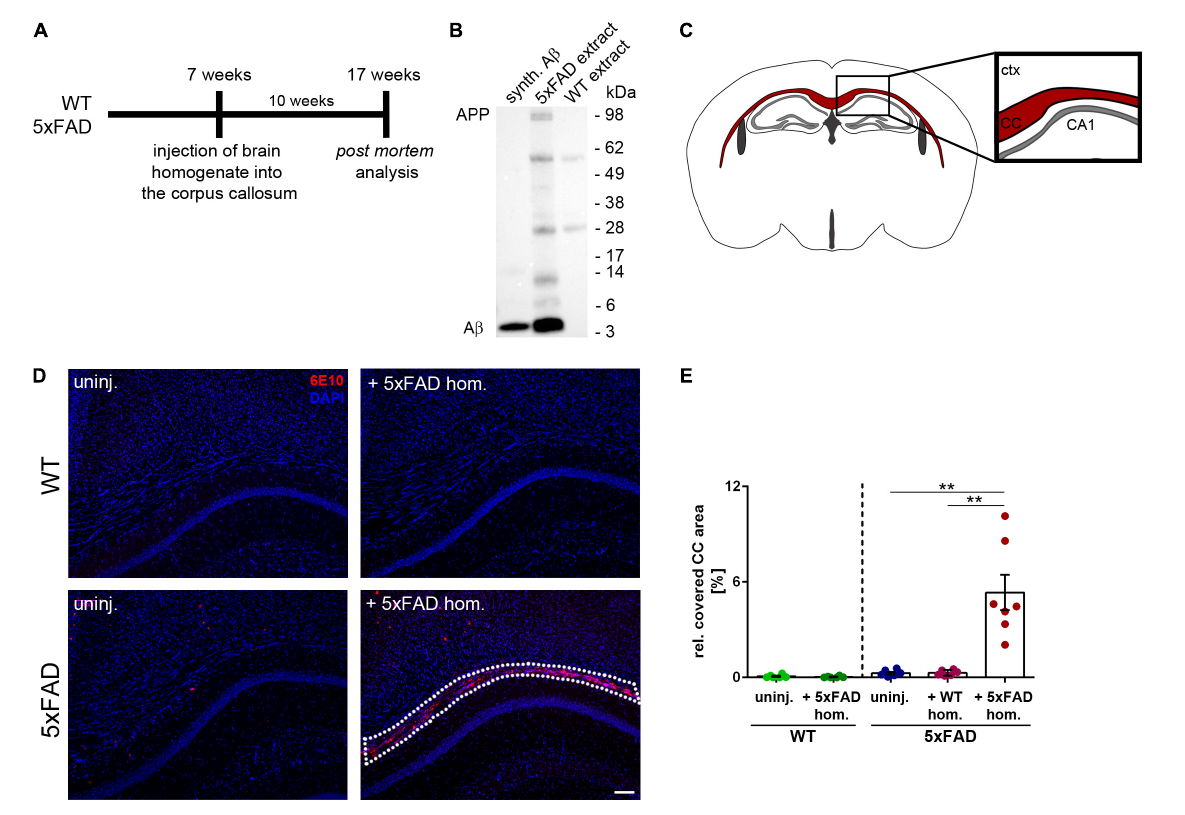
FIGURE1 Intrahippocampal injections of amyloid-beta peptide (A β )-containing brain homogenate induces A β seeding in the corpus callosum (CC). (A) Timeline for the A β seeding experiments. (B) Representative immunoblot from whole brain extracts of aged 5xFAD and WT mice compared to synthetic (synth.) A β (mixture of synthetic A β 1-40 and A β 1-42). Immunoblot was probed with the 6E10 antibody. (C) Illustration of the region of interest (CC; indicated in red) used for subsequent image analysis. Abbreviations: Ctx, cortex; CA1, hippocampal CA1 region; CC, corpus callosum. (D) Fluorescence microscopy visualizing A β -material (6E10; red) of 4-month-old WT and 5xFAD mice, which were either uninjected (uninj.) or injected with A β -containing brain homogenate of an aged 5xFAD mouse (+5xFAD hom.). Dashed line indicates the A β seeding area. (E) Quantification of the A β load relative to the CC. n = 6–7 mice with n = 5 sections analyzed per animal. Each symbol represents data from one animal. Mean ± SEM, Kruskal–Wallis test followed by Dunn’s multiple comparison test, ** p < 0.01. Scale bar 100 µ